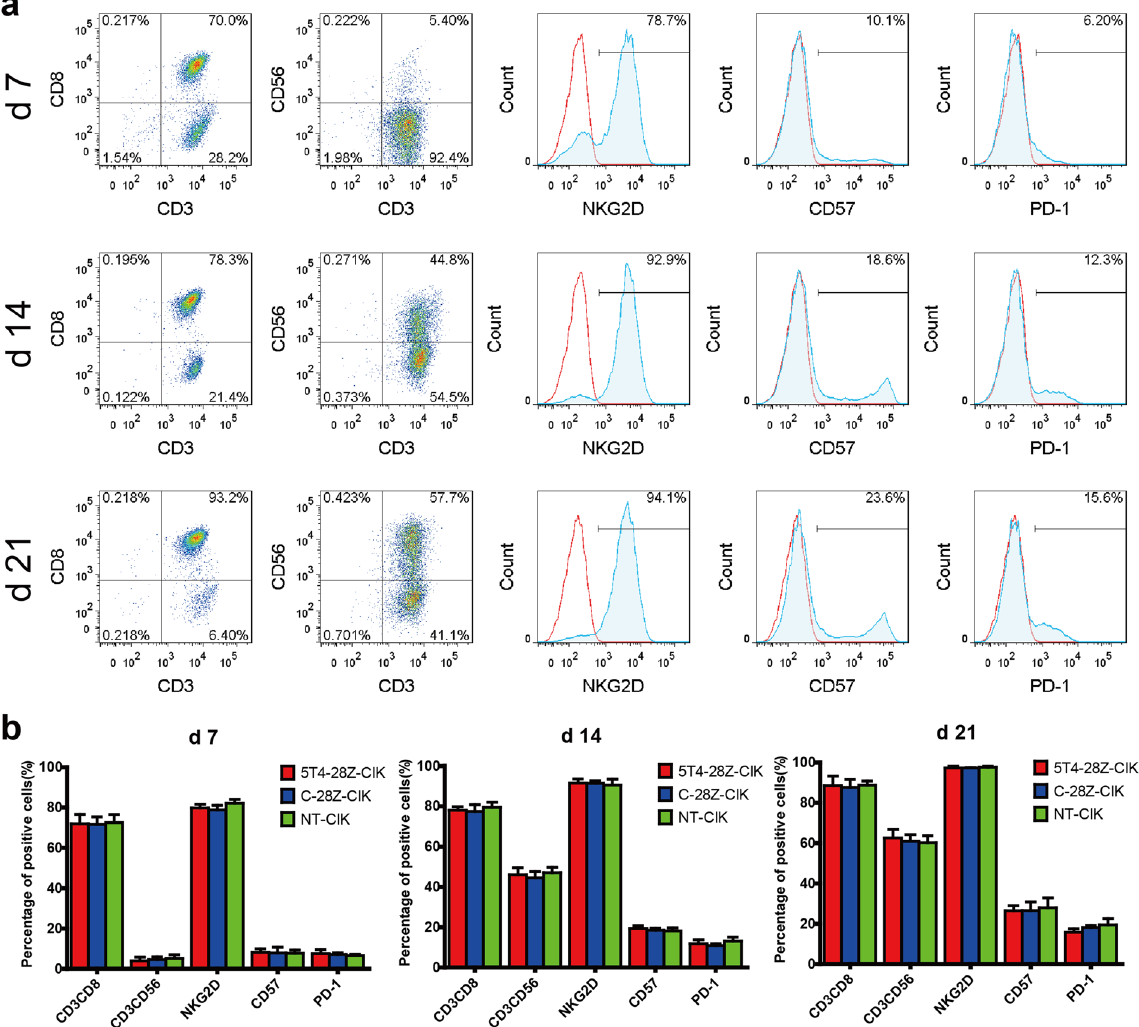
Figure 5. CIK cells maintain their original phenotypes after transduction of CAR genes. The expression of CD3, CD8, CD56, NKG2D, CD57, and PD-1 on CAR-engineered CIK cells and NT-CIK cells was monitored weekly using FACS with diverse fluorochrome-conjugated antibodies or matched isotype control antibodies. ( a ) Characteristic flow plots showing the expression of phenotypic markers in 5T4-28Z-CIK cells on day 7, 14, and 21 of cultivation are presented. ( b ) Histograms show the mean values ± SD of three independent